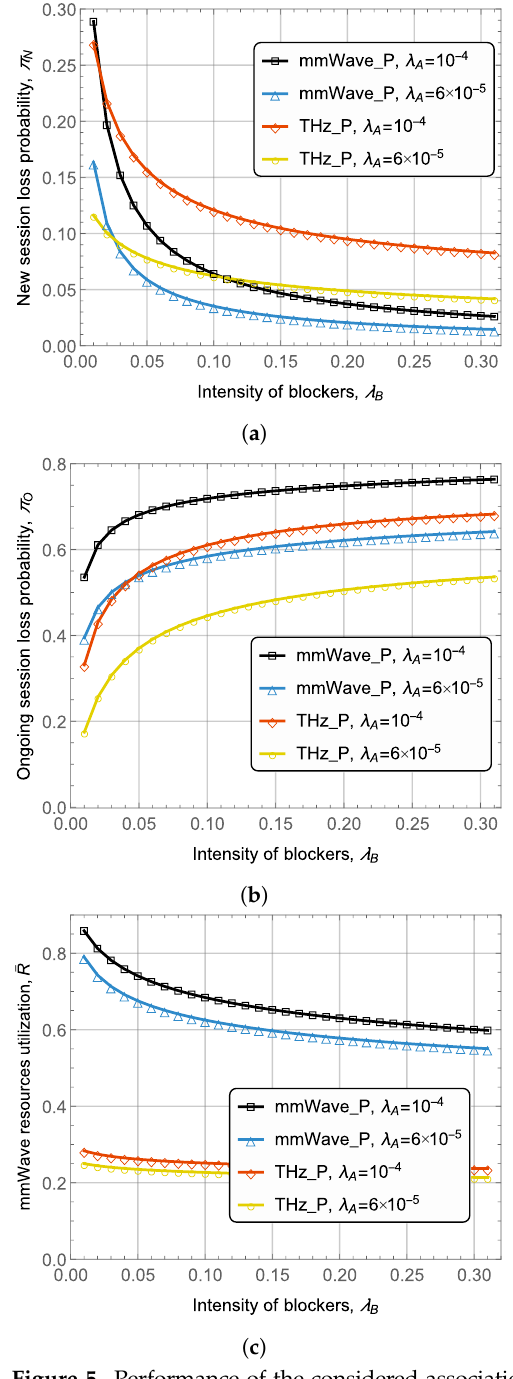
Figure 5. Performance of the considered association schemes as a function of the blocker intensity. ( a ) New session loss probability, ( b ) Ongoing session loss probability, ( c ) System resource utilization, R